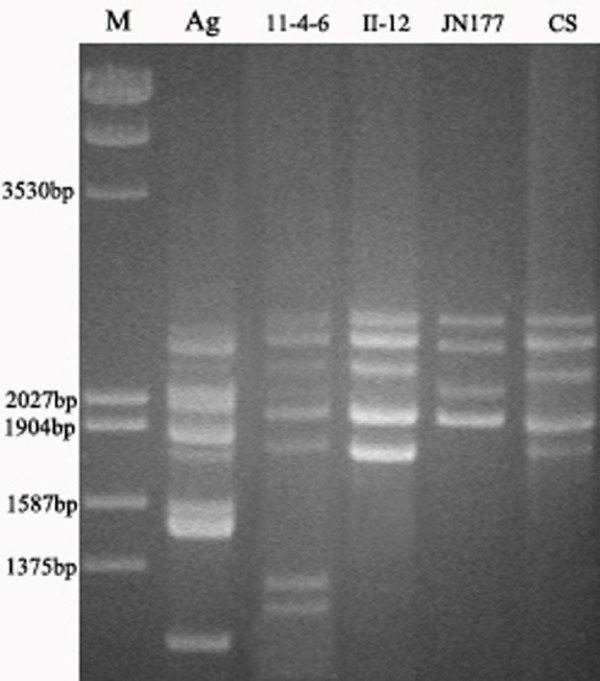
PCR profile of hybrids and parents DNA amplified with the degenerate primer pairs, CS DNA was used as control and M was Marker (EcoR I/Hind III-digested λ DNA).